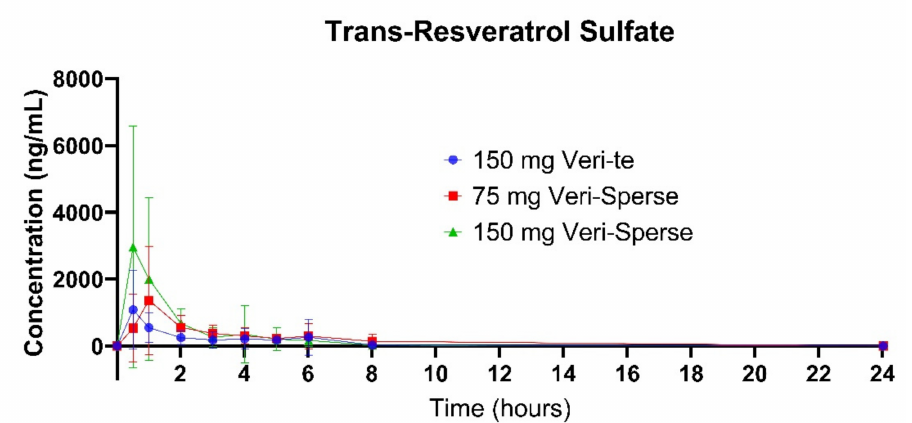
Figure 1. Plasma concentration of the trans-resveratrol sulfate over 24 h after a single dose.